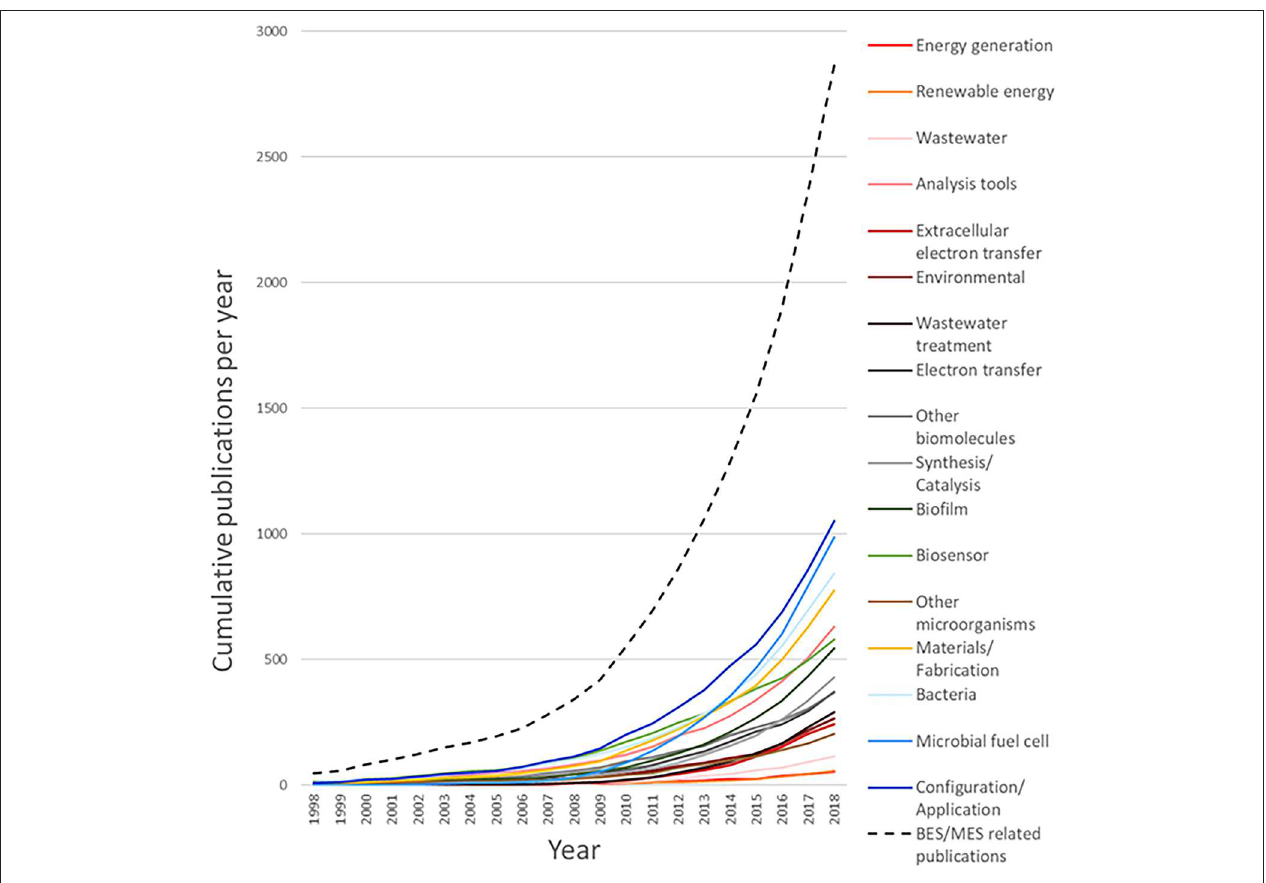
FIGURE 8 | Cumulative publications for selected research areas per